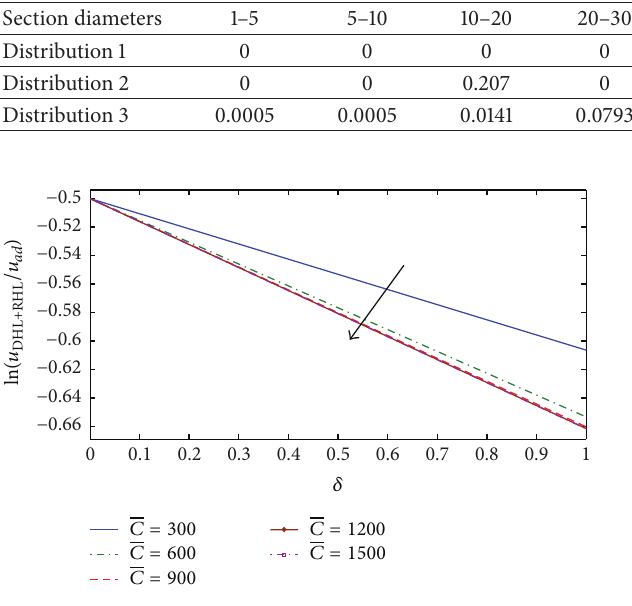
Figure 8: Liquid fuel sectional mass fractions profiles in one- dimensional laminar spray flame propagation, initial size distribu- tion 1.